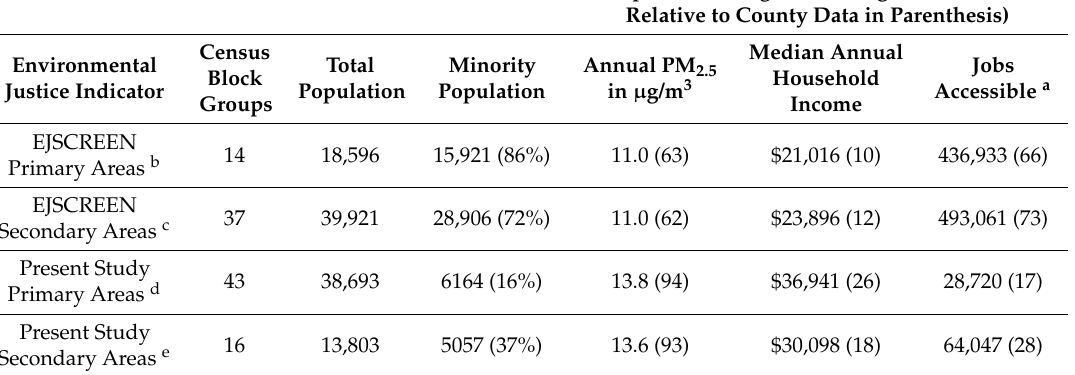
Table 1. Summary of primary and secondary census block groups identified as environmental justice priority areas by EJSCREEN and the present